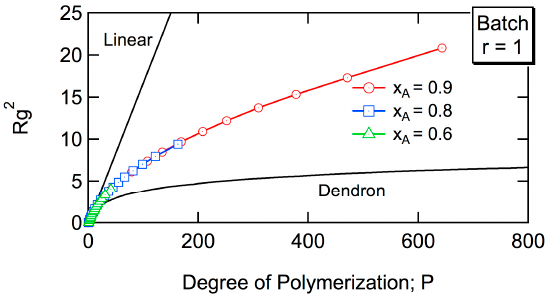
Figure 5. Expected Rg 2 -values of the polymers having P for batch polymerization with r = 1. Redrawn by using the data reported earlier [6].